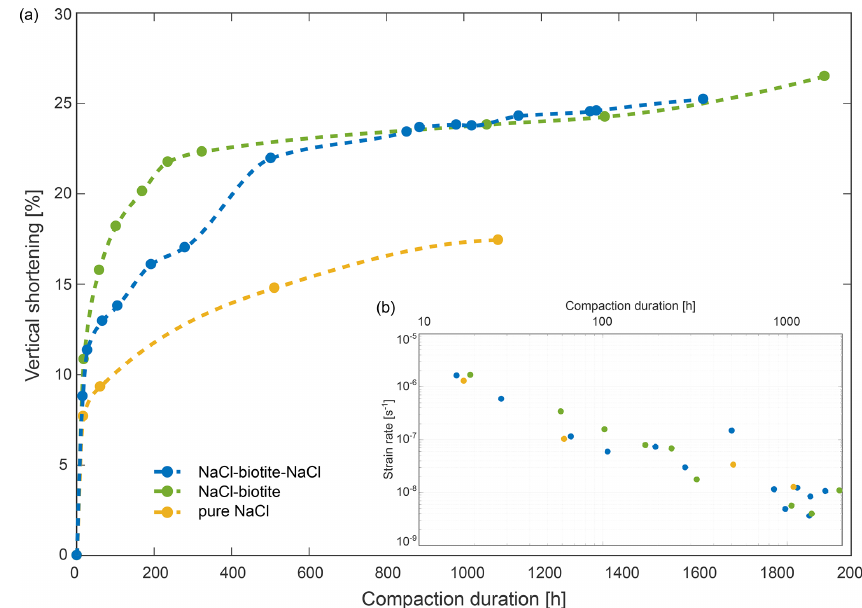
Figure 4. Bulk compaction curves (a) and strain rates (b) derived from µ CT data for the three samples, SBS in blue, SB in green and pure NaCl in yellow. Panel (a) shows the vertical shortening of the samples with progressing deformation. We interpret the non-linearity of the curves as the transition from a loosely packed aggregate where mechanical compaction significantly contributes to the strain rate, to an interlocked aggregate dominated by chemical compaction. Note that all three samples show a similar trend with apparent steady-state deformation established after ∼ 250h. Data points were connected by spline interpolation. In panel (b) , we plotted the corresponding bulk strain rates over the compaction